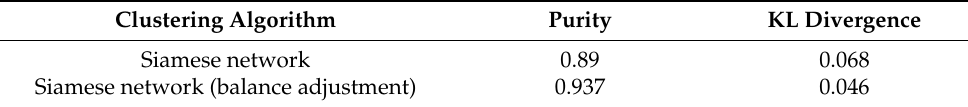
Table 1. Experimental results of sample balance processing. Clustering Algorithm Purity KL Divergence Siamese network 0.89 0.068 Siamese network (balance adjustment)